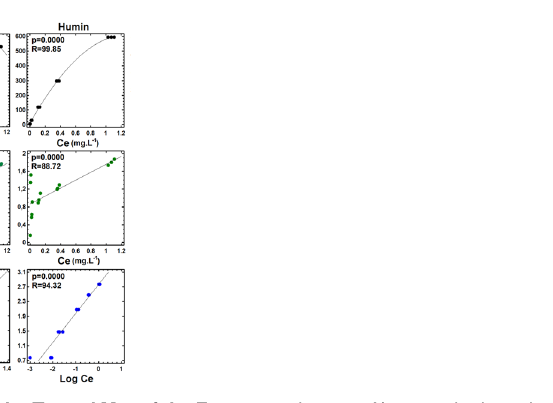
Fig 1. Cd 2+ Adsorption Isotherms for the Tested Materials. From top to bottom: A) general adsorption isotherms, B) linear Langmuir isotherms and C) linear Freundlich isotherms. Retention values were determined through simple linear regression and were significant at p < 0.05 ( n = 15 ).